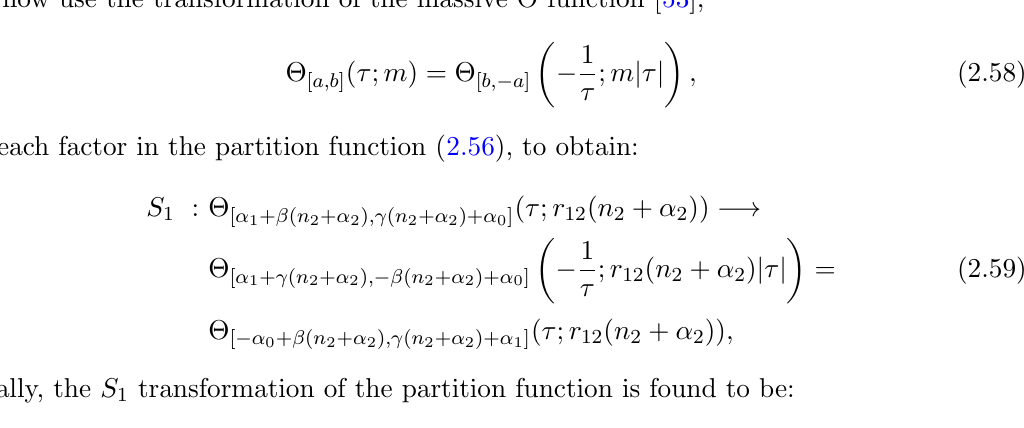
1 , T 2 , S 1 , S 2 for the partition functions Z